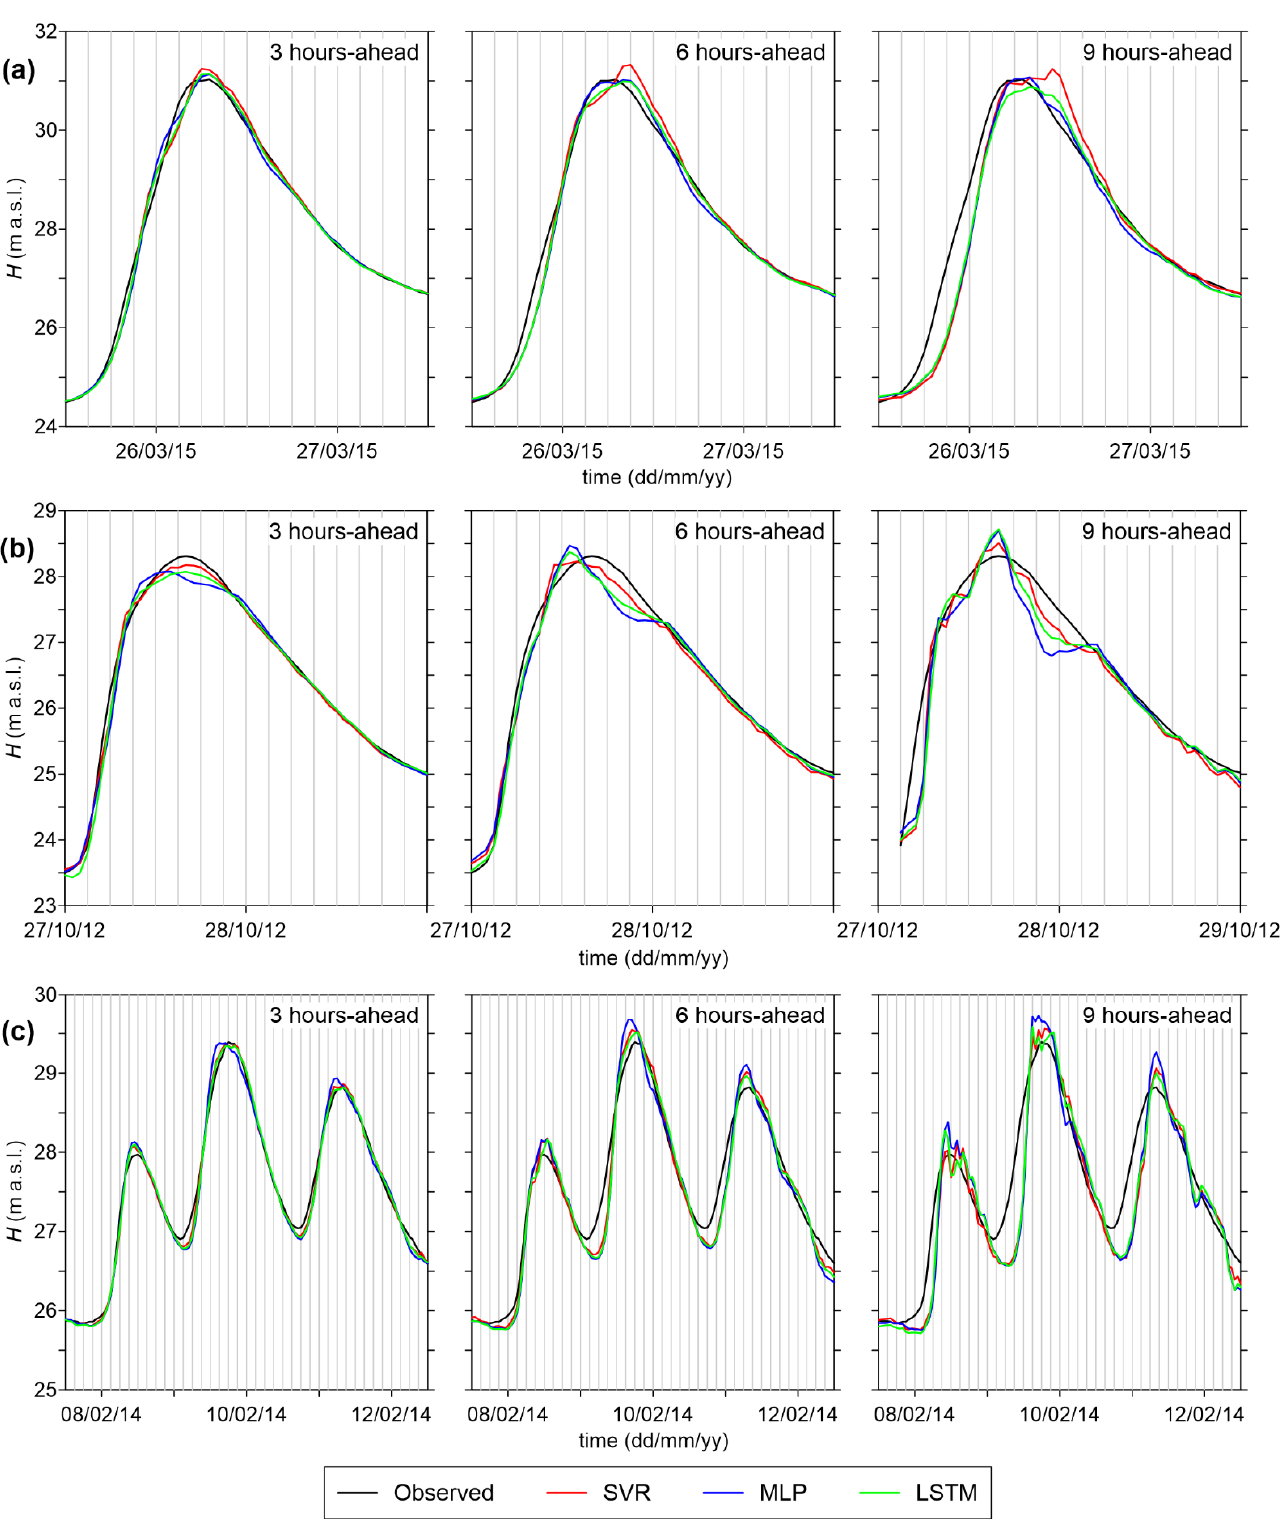
Figure 8. Comparison of observed water levels in Colorno with the forecasted values by SVR, MLP, and LSTM models for the time lags of 3, 6, and 9 h: ( a ) event of 25–28 March 2015 (large Parma River flood); ( b ) event of 26–29 October 2012 (medium Parma River flood); ( c ) event of 7–13 February 2014 (Po River flood). In all plots, vertical grid lines are spaced every 3 h, and the time axis is limited in order to improve readability.